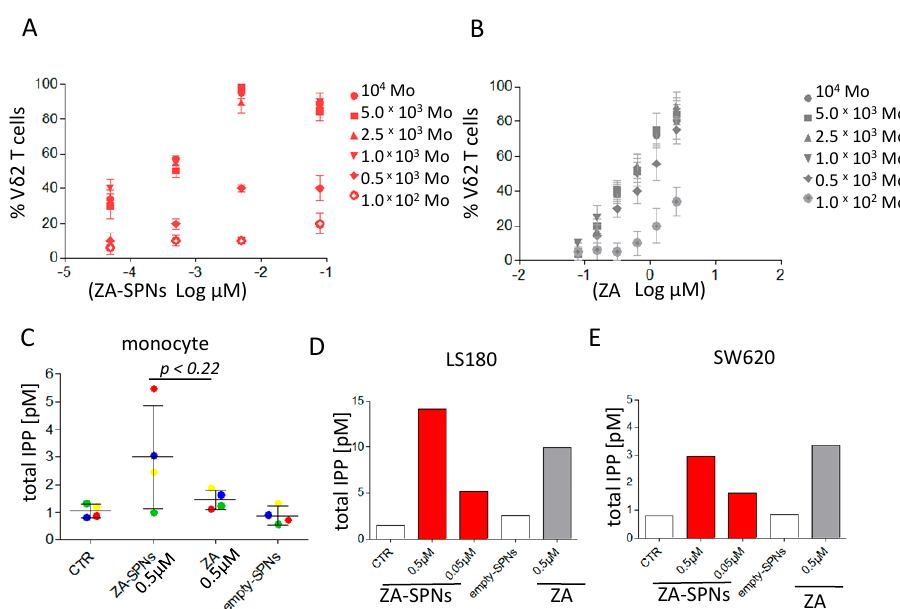
Figure 3. Monocyte requirement for V δ 2 T cell expansion and isopentenyl pyrophosphate (IPP) production in response to ZA-SPNs or ZA. ( A , B ) A total of 10 5 purified T lymphocytes were cultured with different amounts of autologous purified monocytes (Mo), as indicated, in the presence of ZA-SPNs (A) or soluble ZA (B) at different concentrations for 21 days. The percentage of V δ 2 T cells present in culture was evaluated using indirect immunofluorescence and FACS analysis; results are the mean ± SD of T cell populations from six healthy donors. ( C ) A total of 10 6 Mo were incubated for 24 h without (CTR) or with 0.5 μ M ZA-SPNs or with 0.5 μ M soluble ZA or with empty SPNs, and the amount of IPP produced (pM) was evaluated using high performance liquid chromatography/time of flight-mass spectrometry HPLC/TOF-MS. Colors indicate the four Mo donors. The mean ± SD for each condition is also shown. ( D , E ) A total of 5 × 10 5 LS180 or SW620 CRC cells were incubated for 24 h with 0.05 or 0.5 μ M ZA-SPNs or 0.5 μ M soluble ZA, and IPP production was evaluated as in panel (C). Results are shown as pmol of IPP extracted by acetonitrile/total protein content in each cell lysate analyzed using HPLC/TOF-MS. One representative experiment of two performed is shown.